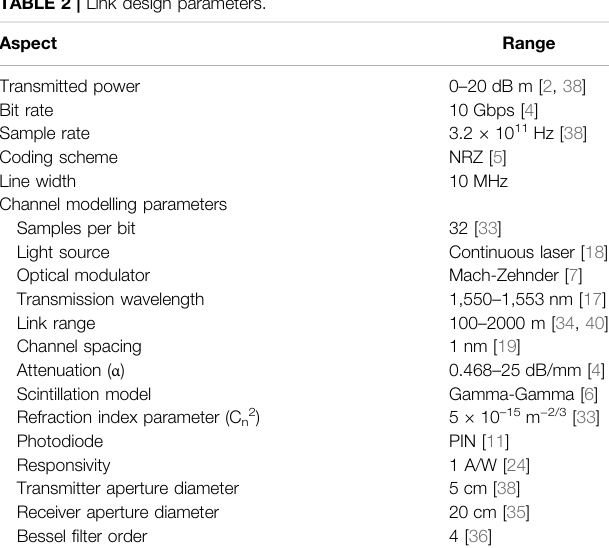
TABLE 2 | Link design